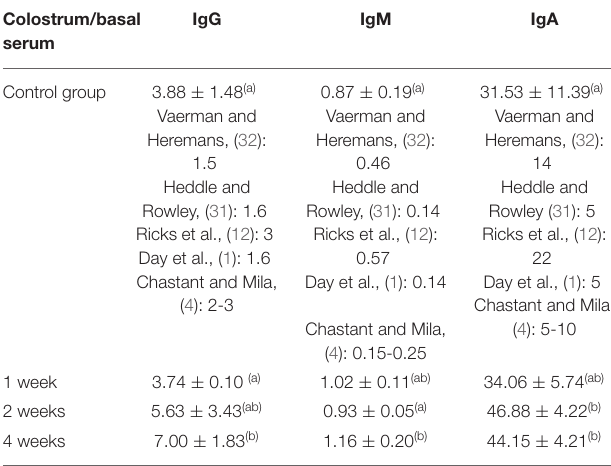
TABLE 5 | Ratio between concentration in colostrum and in basal serum for each Ig class for all study groups. Colostrum/basal